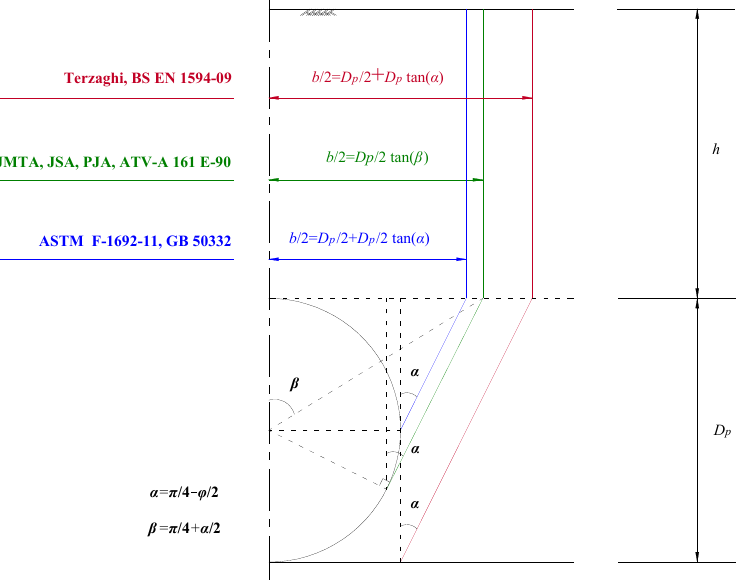
Figure 5. Boundary planes of wedge failure assumed by different authors. JSA: Japan Sewage Association; PJA: UK Pipe Jacking Association;